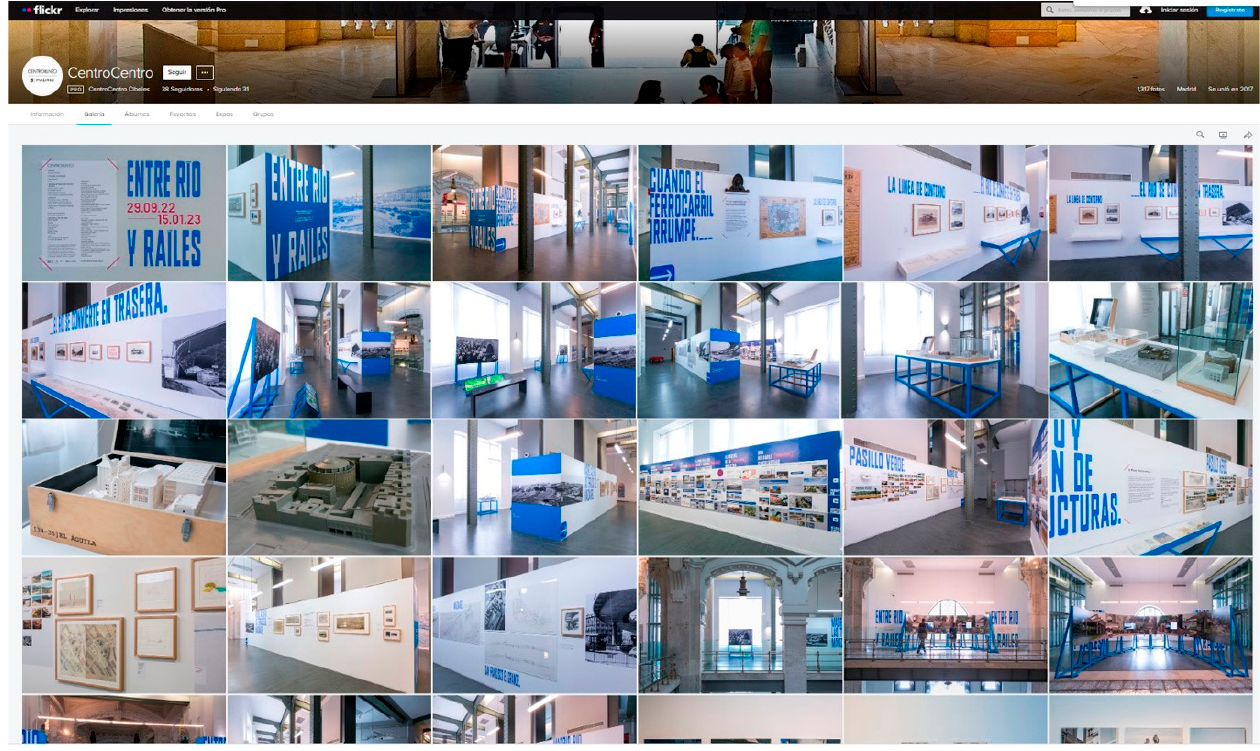
Figure 11. Image sequences of the exhibition “Between river and rails” on the Flickr profile of CentroCentro, an exhibition hall and cultural center of the Madrid City Council, at its headquarters in Plaza de Cibeles. Its curation was the result of a process of storytelling and postproduction of the results of the TRAHERE research.